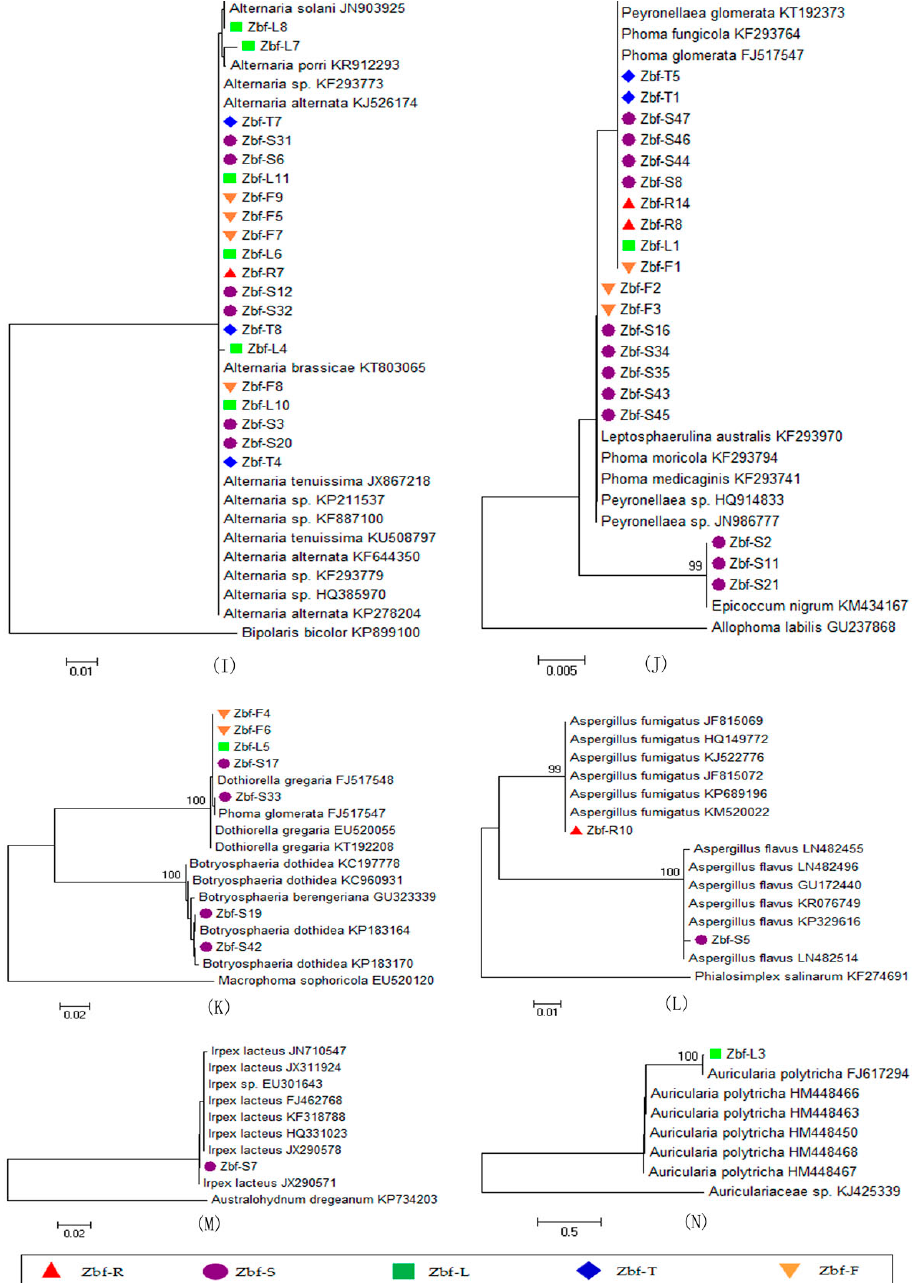
Figure 1. Neighbor-joining phylogenic analyses by internal transcribed spacer (ITS) sequence alignment for the endophytic fungi from Z. bungeanum belonging to Nectriaceae ( A ); Bionectriaceae ( B ); Valsaceae ( C ); Diaporthaceae ( D ); Xylariaceae ( E ); Incertae sedis Hypocreales ( F ); Pleosporaceae ( G ); Didymellaceae ( H ); Phaeosphaeriaceae ( I ); Morosphaeriaceae ( J ); Botryosphaeriaceae ( K ); Aspergillaceae ( L ); Incertae sedis Polyporales ( M ); and Auriculariaceae ( N ).